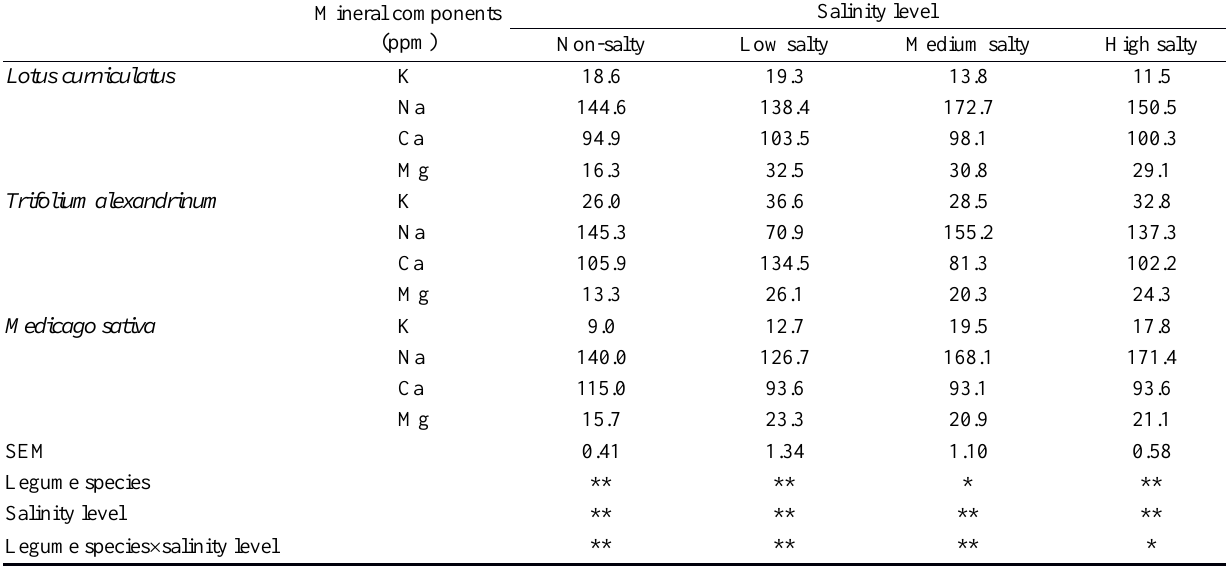
Table 3. Mineral components of legume plants cultivated from different salt-affected